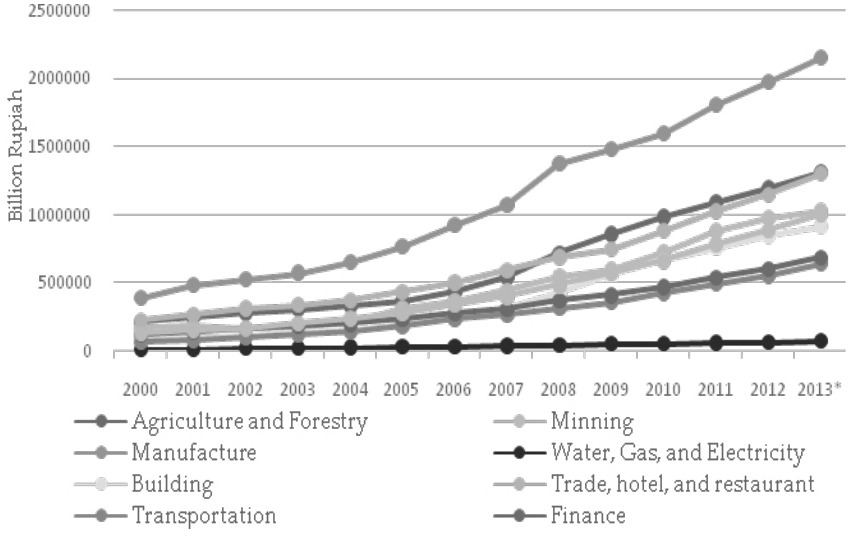
Figure 1: Indonesia GDP based on Constant Price 2000, 2000-2014. Source: Indonesia Statistic Bureau, 2017